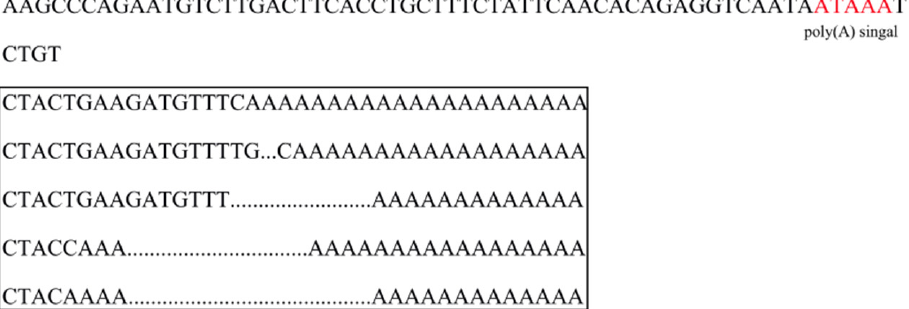
Figure 2. Characterization of the PLAG1 3 ′ -UTR region in Hu sheep: black underlines represent AU-rich element (ARE) sequences; black boxes indicate the five different base sequences plus poly(A) tails; two parts (2739 bp and 3275 bp) of the sequence of PLAG1 are omitted. Primers were designed to screen for SNPs by DNA pool sequencing, and g.8795C>T was identified in the 3 (cid:48) -UTR region of the PLAG1 gene. In the Hu lamb population, three genotypes (CC, CT, and TT) were identified at the g.8795 locus (Figure 3a) with genotype frequencies of 0.8466 (298/352), 0.1477 (52/352), and 0.0057 (2/352), respectively (Figure 3b). The lambs with the CT genotype exhibited higher birth weight (3.42 ± 0.08) and weaning weight (13.51 ± 0.39) than those with the CC genotype (3.13 ± 0.03, p < 0.05 and 12.67 ± 0.17, p > 0.05, respectively) in a population of 352 Hu sheep. Further analysis revealed that the birth and weaning weights of different genotypes at the g.8795 locus were also significantly different between ram lambs and ewe lambs. Specifically, ram lambs with CT genotypes exhibited higher birth weight and weaning weight (3.56 ± 0.11 and 15.54 ± 0.48, respectively) than those with CC genotypes (3.22 ± 0.05 and 14.39 ± 0.20, respectively, p < 0.05) among 168 ram lambs, and ewe lambs with the CT genotype exhibited higher birth weight (3.29 ± 0.10) and weaning weight (12.14 ± 0.42) than those with the CC genotype (3.02 ± 0.04 and 11.19 ± 0.19, respectively; p < 0.05) among 191 ewe lambs. Furthermore, twin lambs with the CT genotype exhibited higher birth weight (3.53 ± 0.11) and weaning weight (13.32 ± 0.55) than those with the CC genotype (3.26 ± 0.05, p < 0.05 and 13.14 ± 0.23, p > 0.05, respectively) among 177 twin